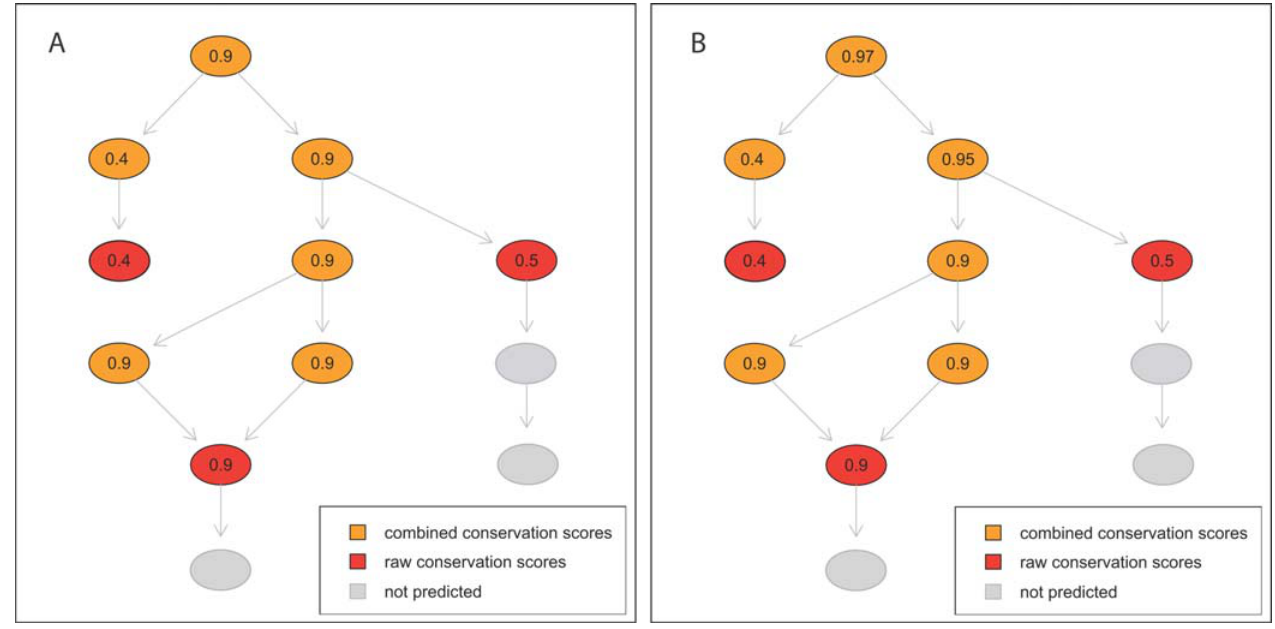
Figure 9. Selective and Consensus Combination Schemes. Examples of selective (A) and consensus (B) raw score combinations. (A) and (B) both show a subgraph of the full gene ontology. Raw function conservation scores were mapped to specific GO terms (red). We compute combined function conservation scores for more general GO terms (orange) using the selective and consensus combination schemes. Grey nodes indicate GO terms, that were not predicted by the method.